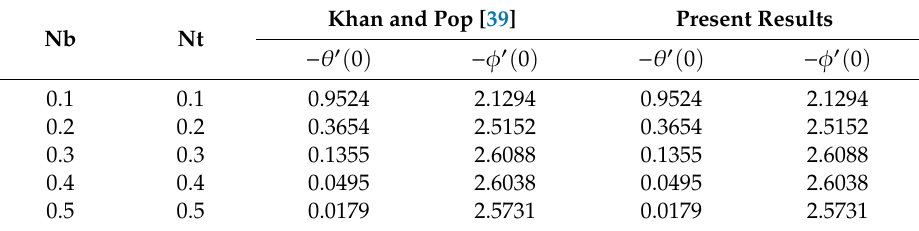
Table 2. Values of )0(